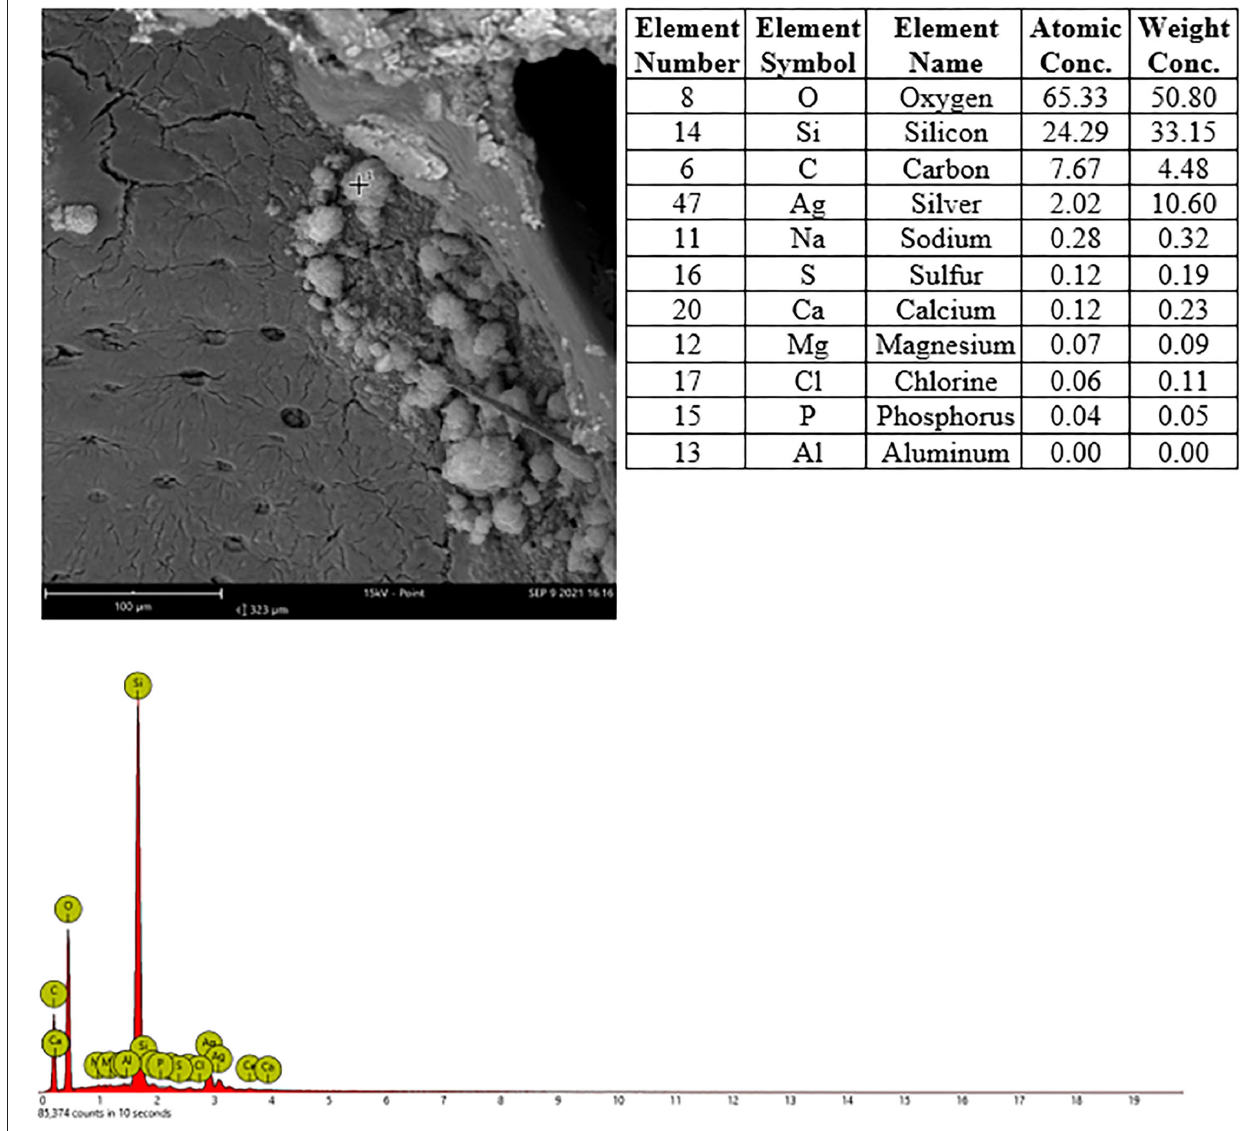
Grade 4, Marked: This corresponds to a histopathologic change that is a dominant but not an overwhelming feature of the tissue. For multifocal or diffusely distributed lesions, this grade was used for processes where between ∼ 50 and 95% of the tissue in an average high-power field was involved. Grade 5, Severe: This corresponds to a histopathologic change that is an overwhelming feature of the